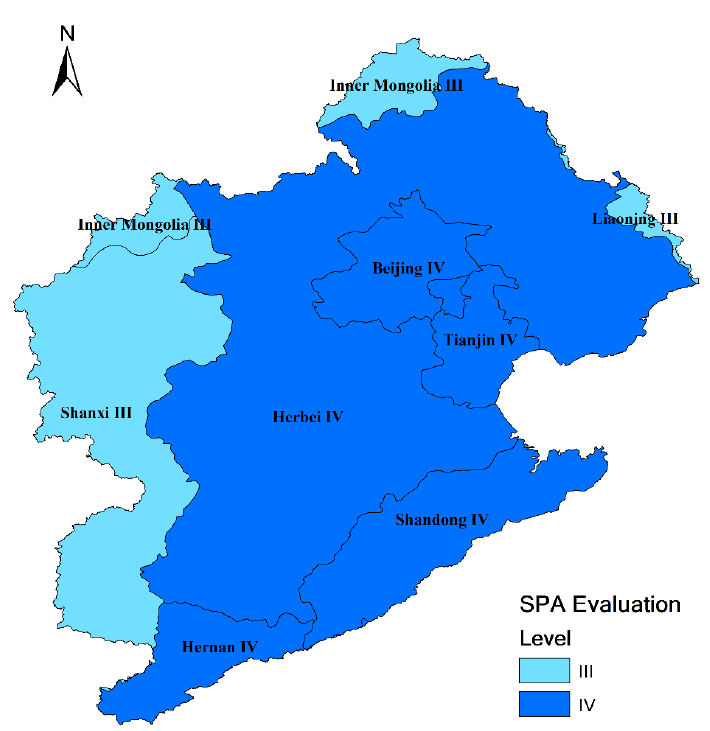
Figure 3. Assessment of agricultural water resources carrying level in the baseline year.